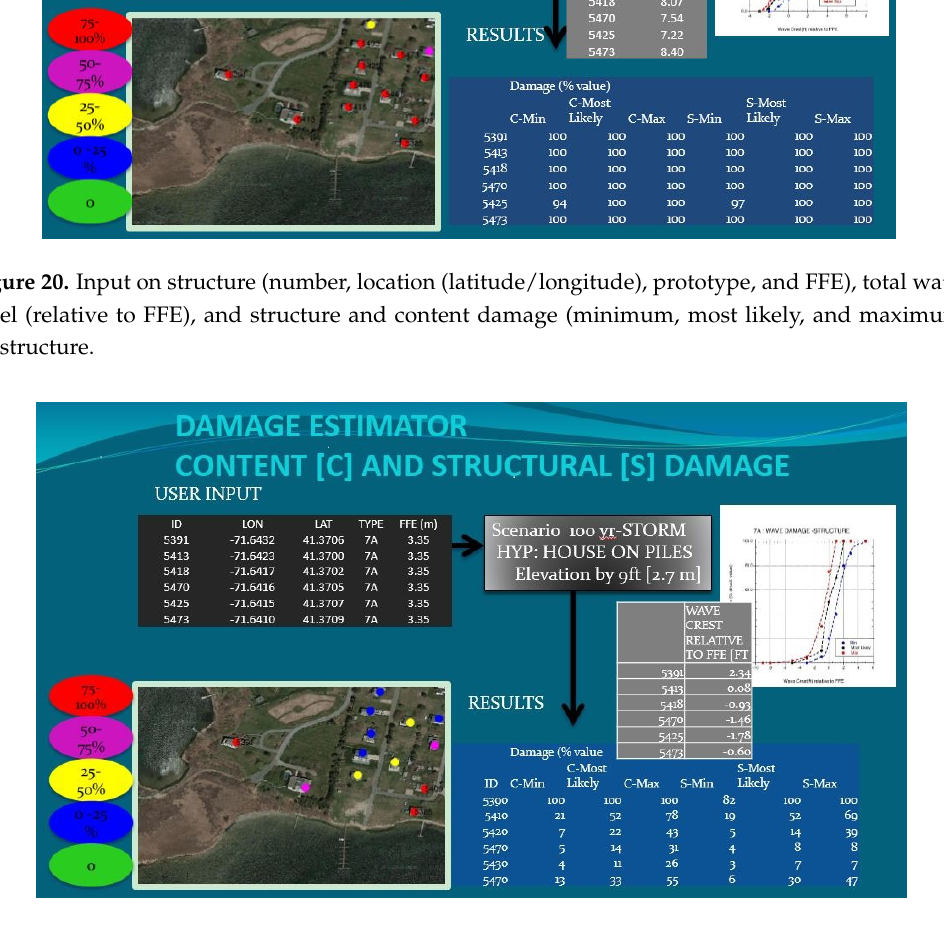
Figure 21. Input on structure (number, location (latitude/longitude), prototype (all assumed 7A with elevations of 2.7 m, and FFE), total water level (relative to FFE), and structure and content damage (minimum, most likely, and maximum) by structure.